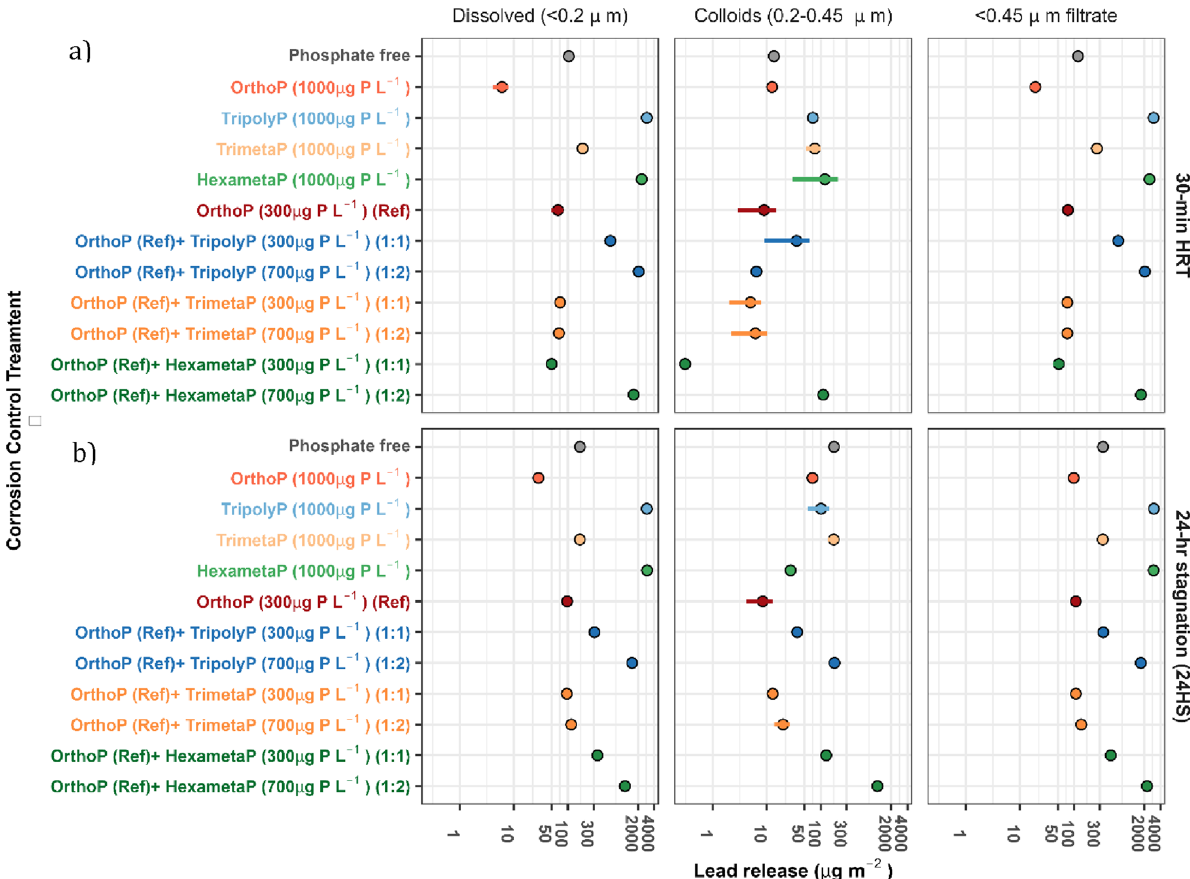
Figure 2. Median mass lead release per unit surface area (log-scale) during a ( a ) 30 min and ( b ) 24-h reaction at pH 7.5 and DIC 5 mg C L −1 from the CSTR. We compared lead release from a phosphate free condition, orthophosphate (1000 µg P L −1 ) and three polyphosphates (1000 µg P L −1 ). We also compared blends of orthophosphate (300 µg P L −1 ) and polyphosphates (300 or 700 µg P L −1 ) against orthophosphate (300 µg P L −1 ). Each set represents at least two reactor runs, and error bars span the median absolute deviation of measurements. Tabulated data can be found in Table